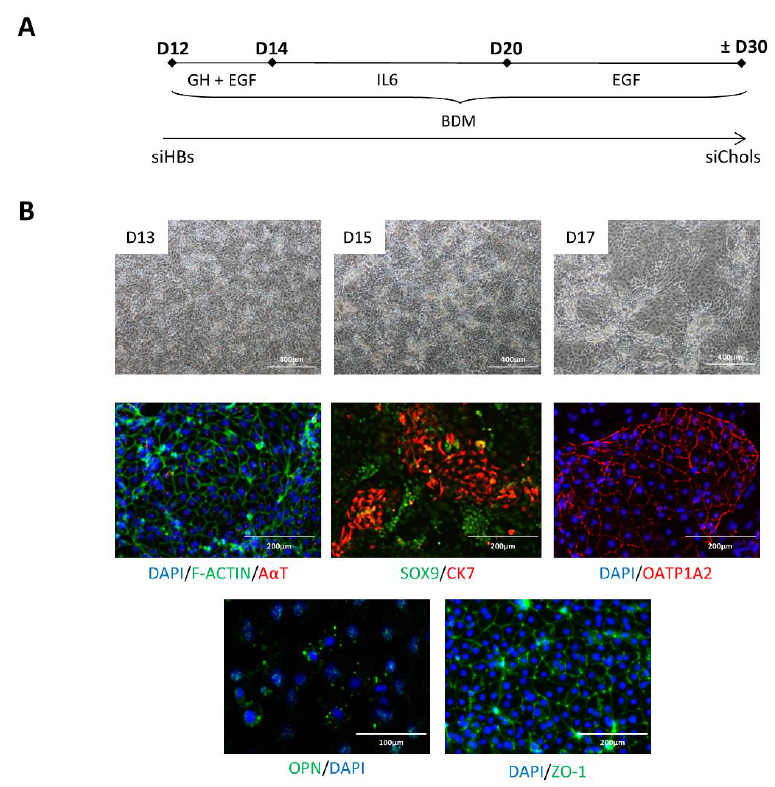
Figure 3. siHB differentiation into siChols. ( A ) Schematic representation of the differentiation protocol. ( B ) Cell morphology and immunostaining showing the expression of cholangiocyte-specific markers in siChols. BDM: biliary differentiation medium.